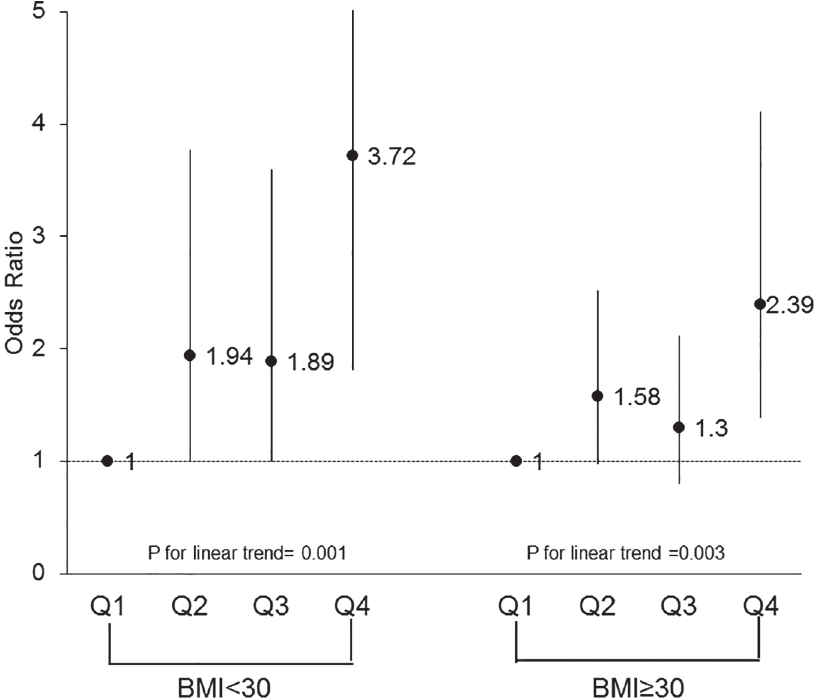
Fig 3. dds ratios above the norm for health-related quality of life physical component score according to cardiorespiratory fitness levels and body mass index among females. Logistic regression adjusting for age, body mass index, smoking status, hypertension, and physical inactivity was used to obtain odds ratios and the p-value for the trend analysis, Q, quartile.